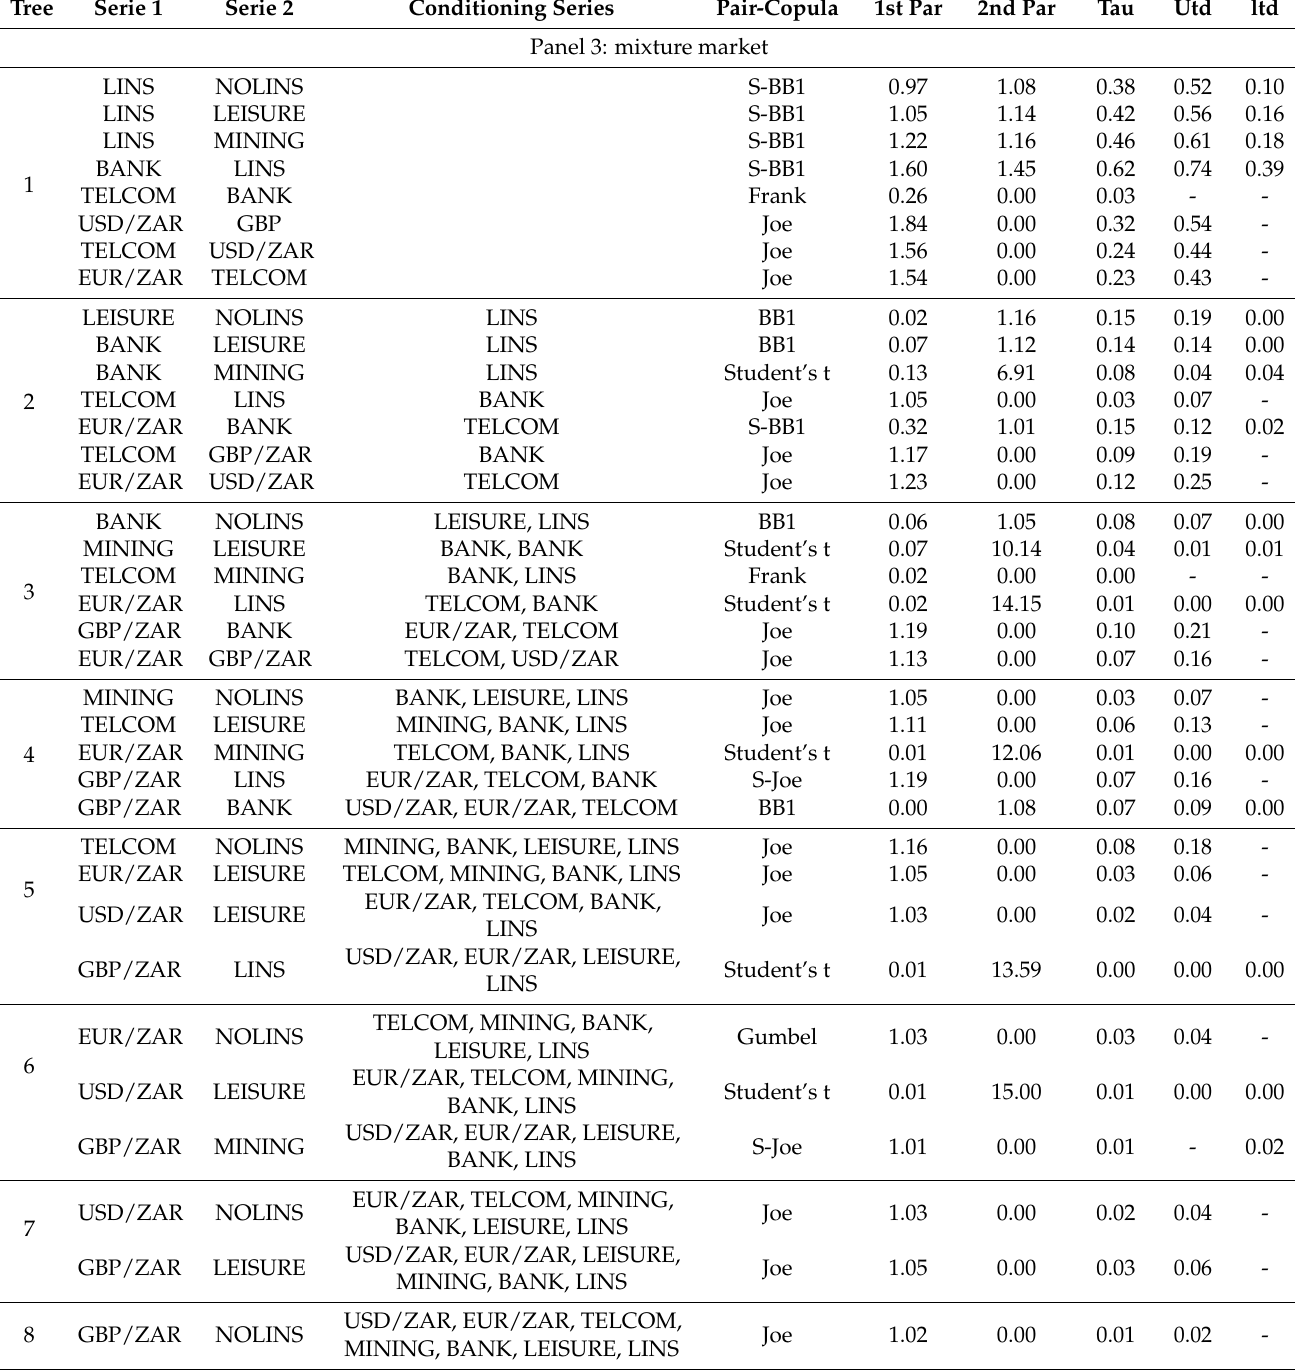
Note: Table A1 exhibits the dependence structure analysis using the R-vine copula. Several bivariate copulae are used: BB1 denotes Clayton–Gumbel, BB1_270 denotes the rotated Clayton–Gumbel, S-BB1 represents the